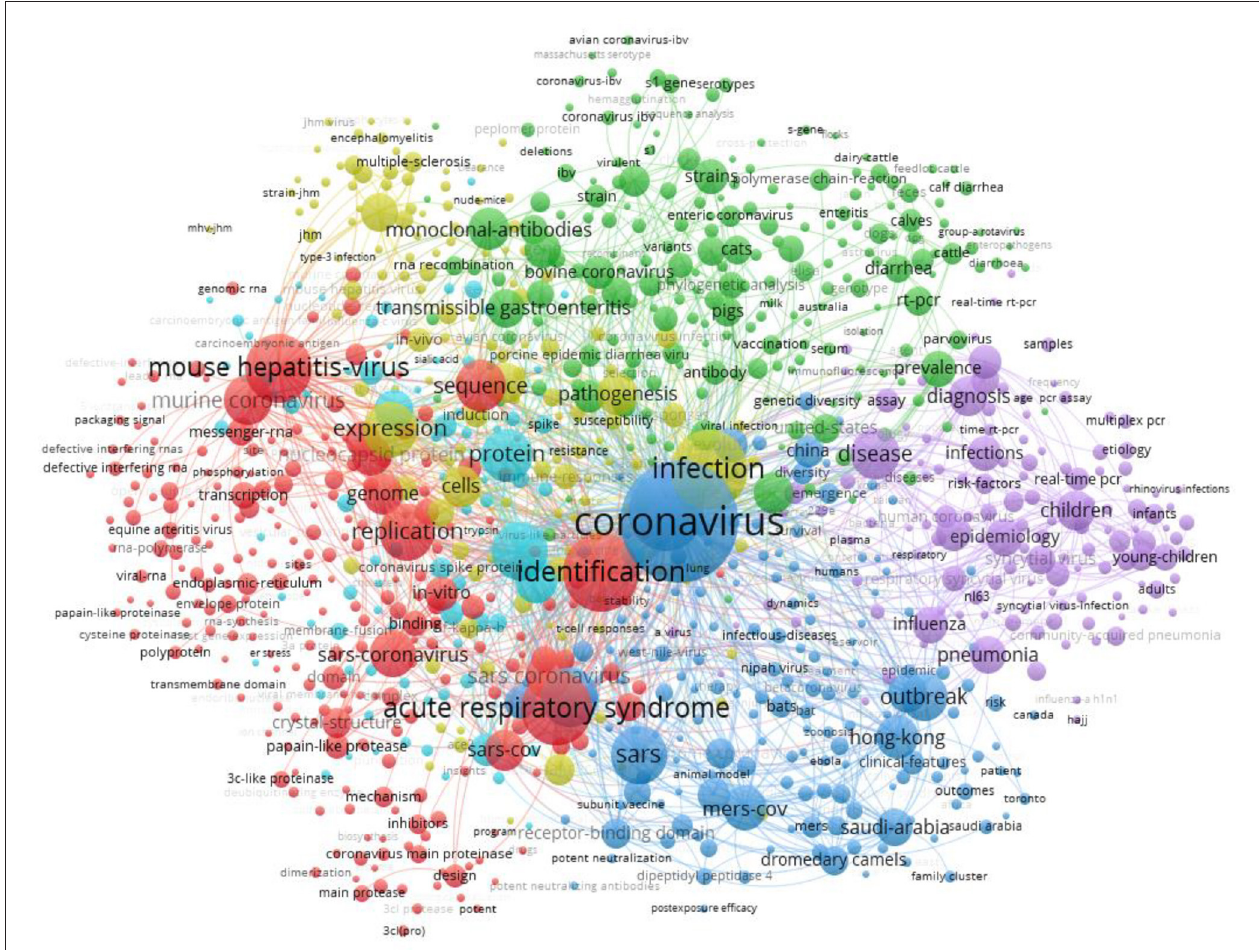
FIGURE 6 | Keyword co-occurrence network in CoV-related